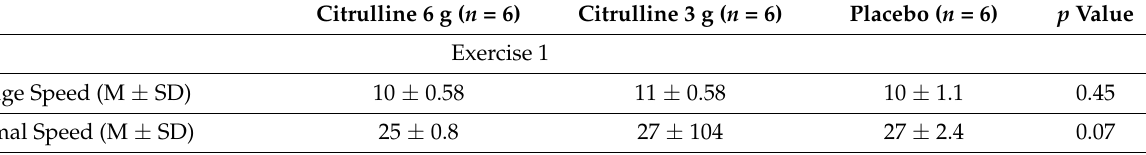
Table 4. Exercise-test GPS metrics for all